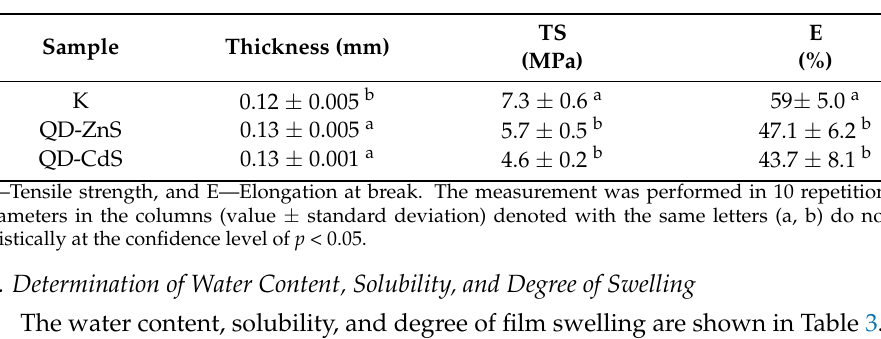
Table 2. Mechanical properties of the foils.